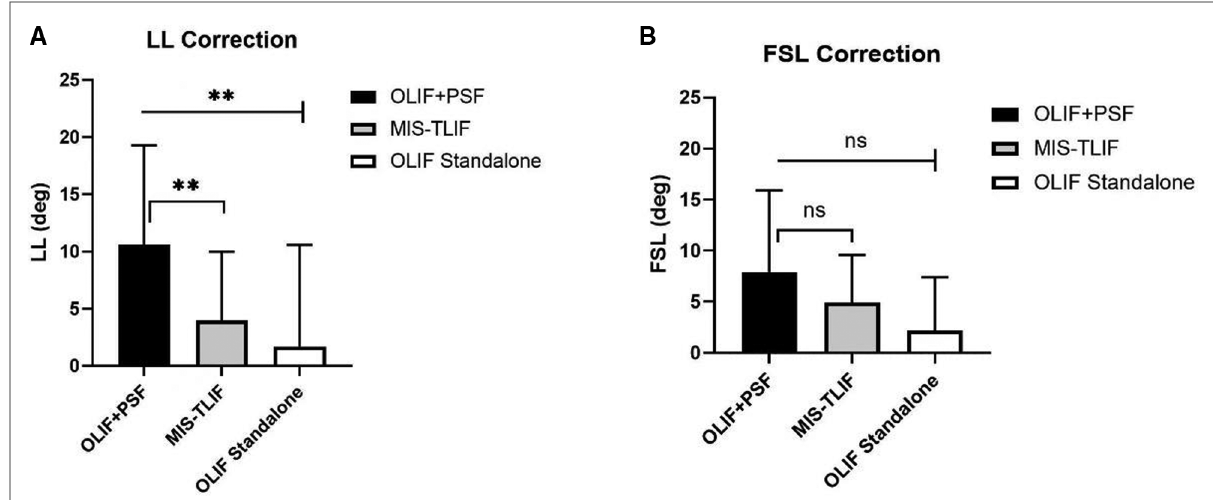
FIGURE 5 Post-operative correction of LL, FSL, in OLIF+PSF, OLIF Standalone and MIS-TLIF. A. LL Correction. B. FSL